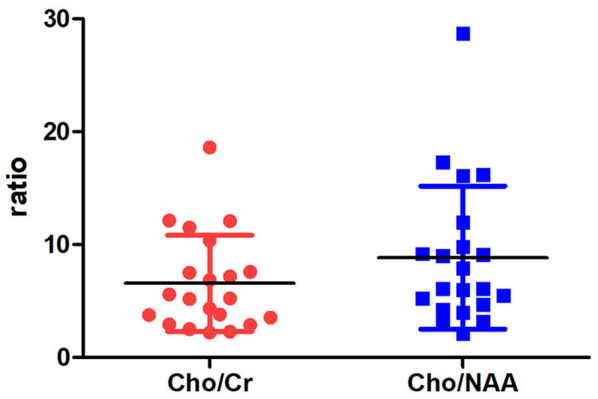
The distribution of Cho/Cr and Cho/NAA ratio.